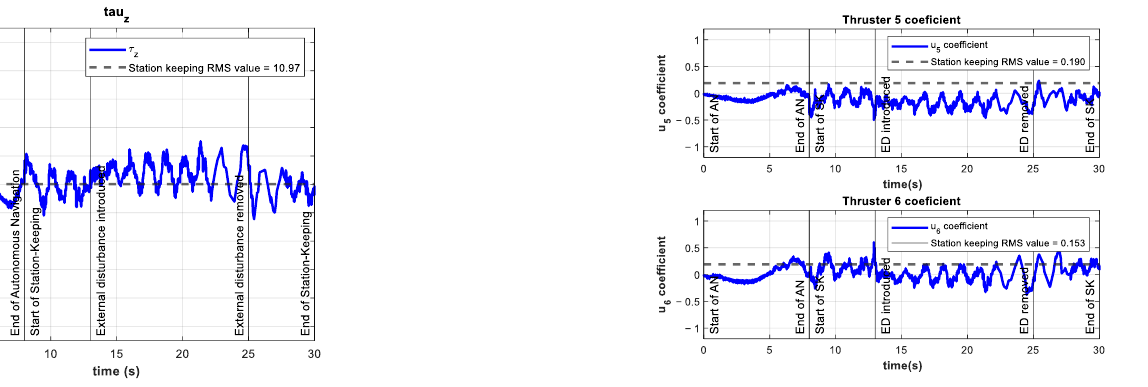
Figure 14. Experimental results for depth station-keeping with an external disturbance of ∼ 10 N in-